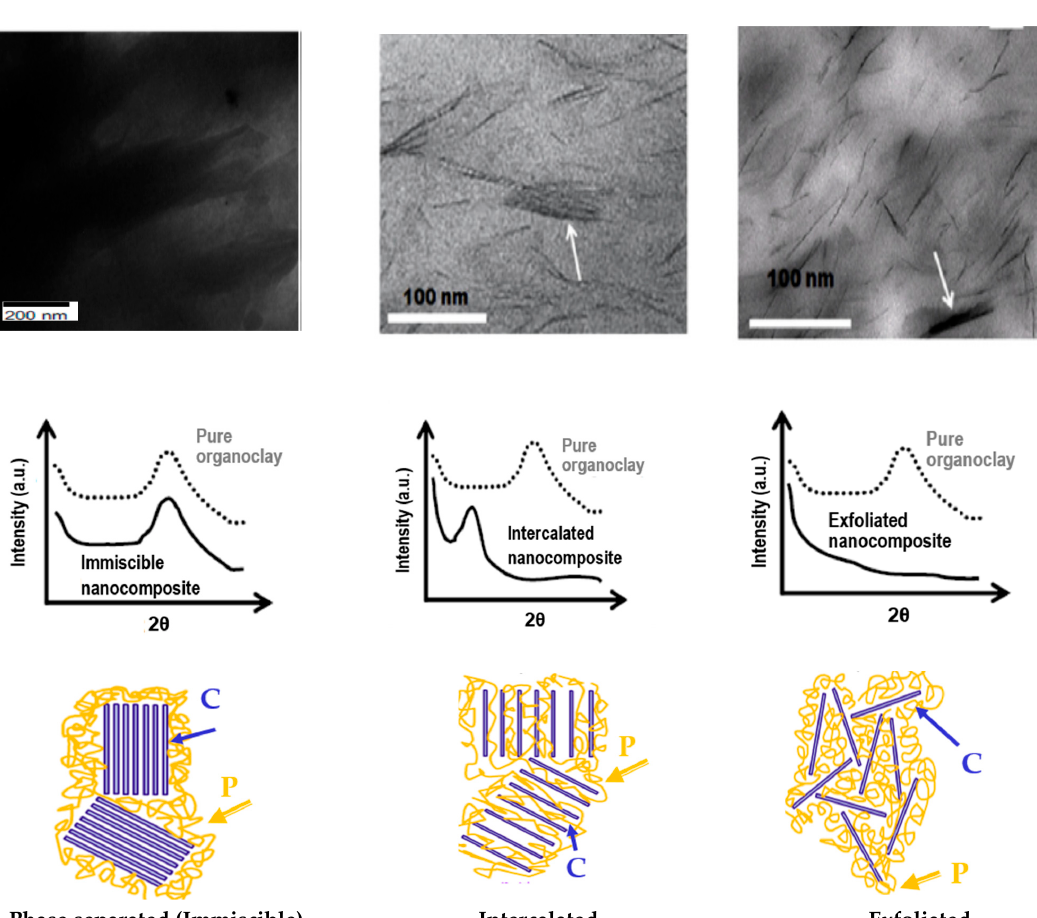
Figure 9. Illustration of various structures of organoclays (C) with polymers (P) ( bottom ) and their corresponding WXRD ( middle ) and TEM images [7,26] ( upper ).